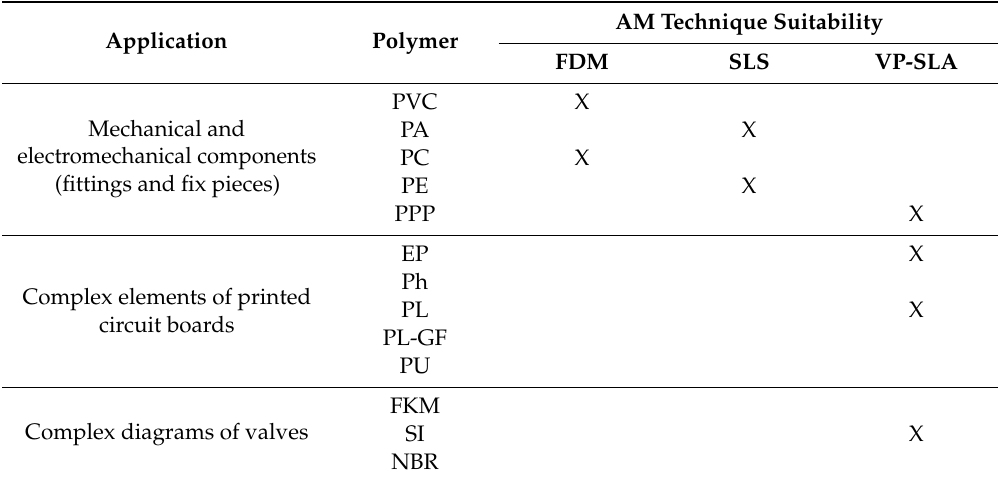
Table 1. Polymers, related applications and AM technique suitability